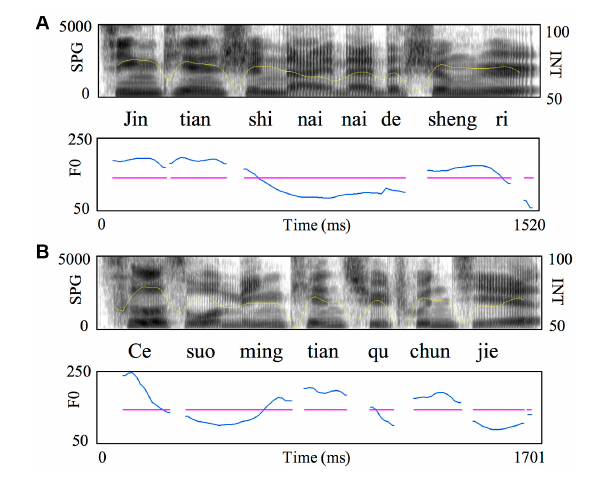
FIGURE 1 | Acoustic properties of example speech stimuli. Broadband spectrograms (SPG, range: 0–5 kHz), intensity envelopes (INT, range: 50–100 dB) and F 0 contours (range: 50–250 Hz; blue: natural; purple, flat) are displayed for (A) normal sentence and the pitch-flattened counterpart, and (B) word list sentence and the pitch-flattened counterpart. Syllables are marked in pinyin (the Chinese phonetic transcription